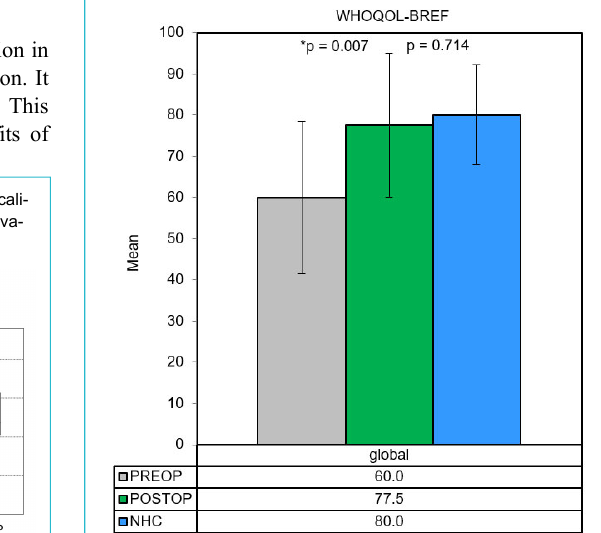
Figure 9: Mean WHO Quality of Life (WHOQOL-BREF) scores of the SSD patients assessed preoperatively and 12 months after ac- tivation as well of the normal hearing control group